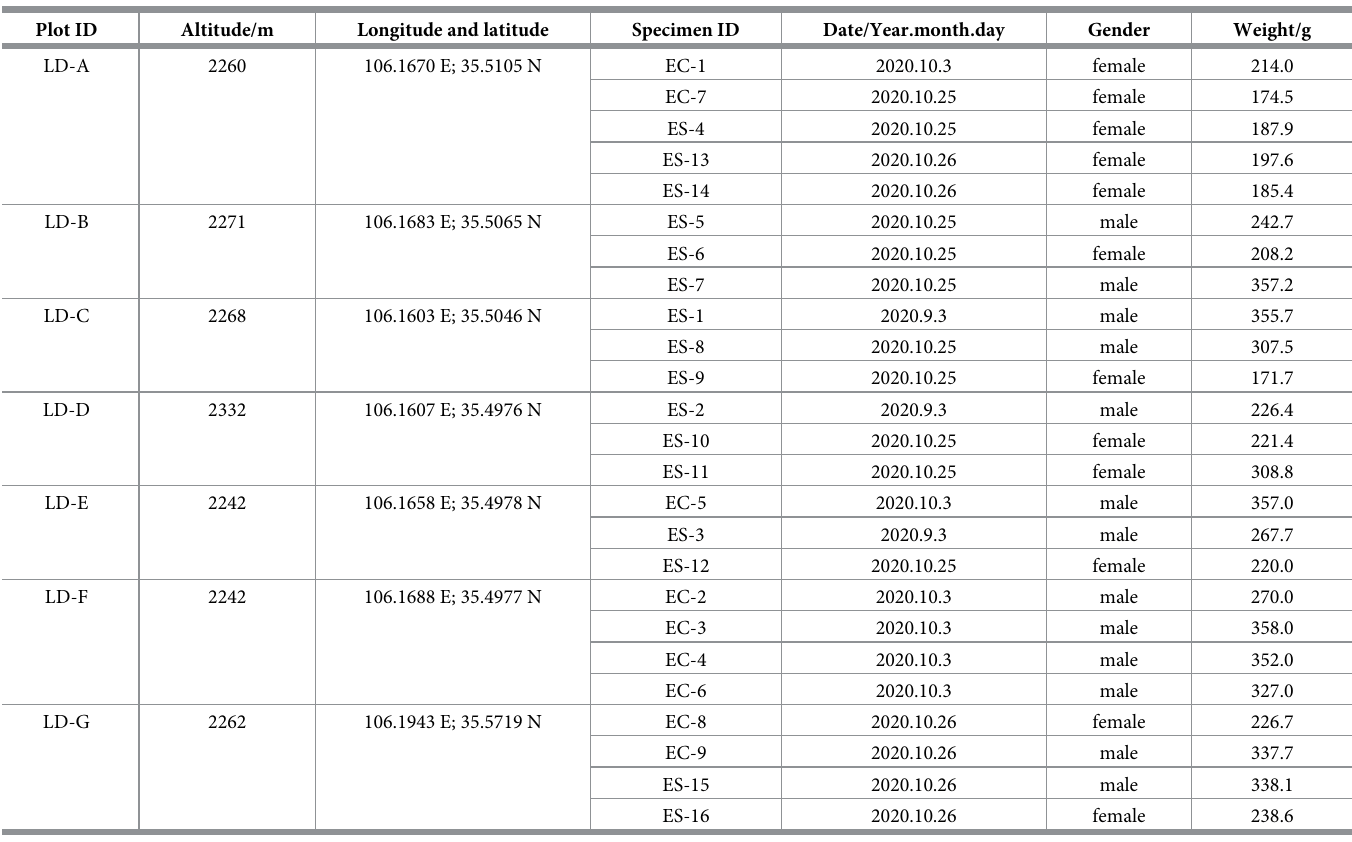
Table 1. Specimen information. Plot